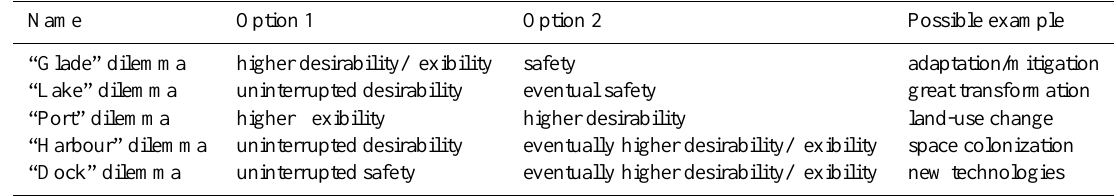
Table 1. Preview of dilemma types discussed in the article. Name